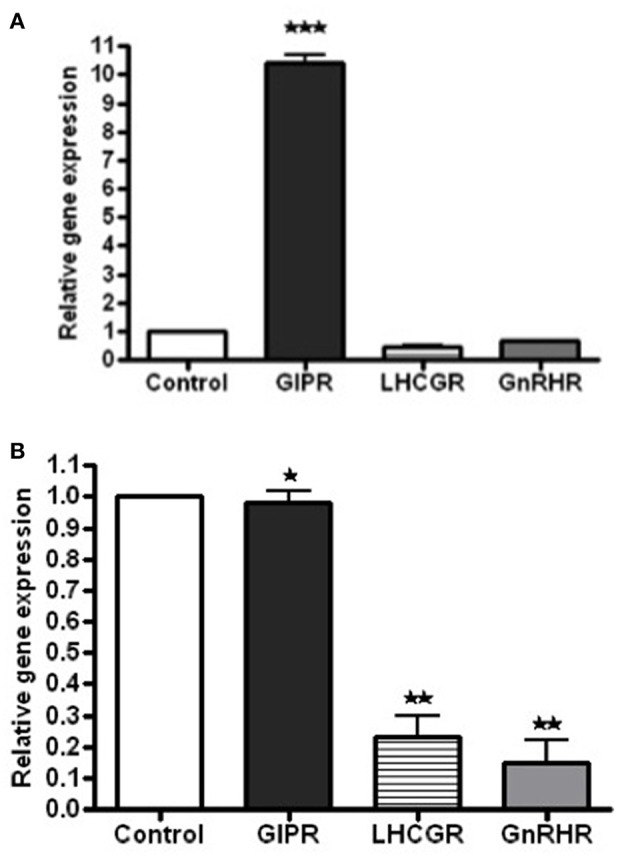
Messenger RNA (mRNA) expression levels for the receptors of GIP, LHCG, GNRH expression compared to control (pool of 5 control adrenals from Clontech) in the left and right adrenal gland tissue extracts of the patient, as determined by real-time quantitative PCR. (A) When compared to pool of normal adrenal glands, GIPR overexpression was found by RT-PCR in the right adrenal gland [10.5 fold higher than control adrenal tissue (***p < 0.05)]. (B) In the patient's BMAH/myelolipomas tissues in the left adrenal gland no increased expression of GIPR was found (*p > 0.05) and reduced expression of LHCGR and GnRHR (**p < 0.05) were found when comparing with those in the control tissues.